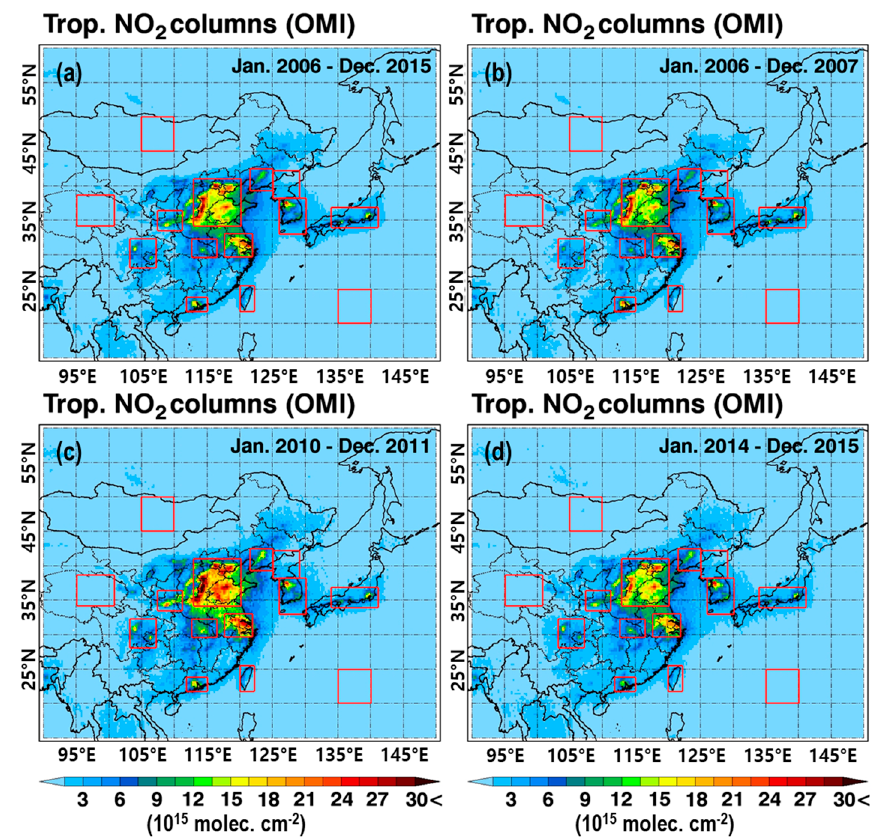
Figure 2. ( a ) Tropospheric NO 2 columns 10-year averaged ( a ) from 2006 to 2015, and 2-year averages for ( b ) 2006, ( c ) 2010, and ( d ) 2014 (unit: 10 15 molec. cm -2 ).